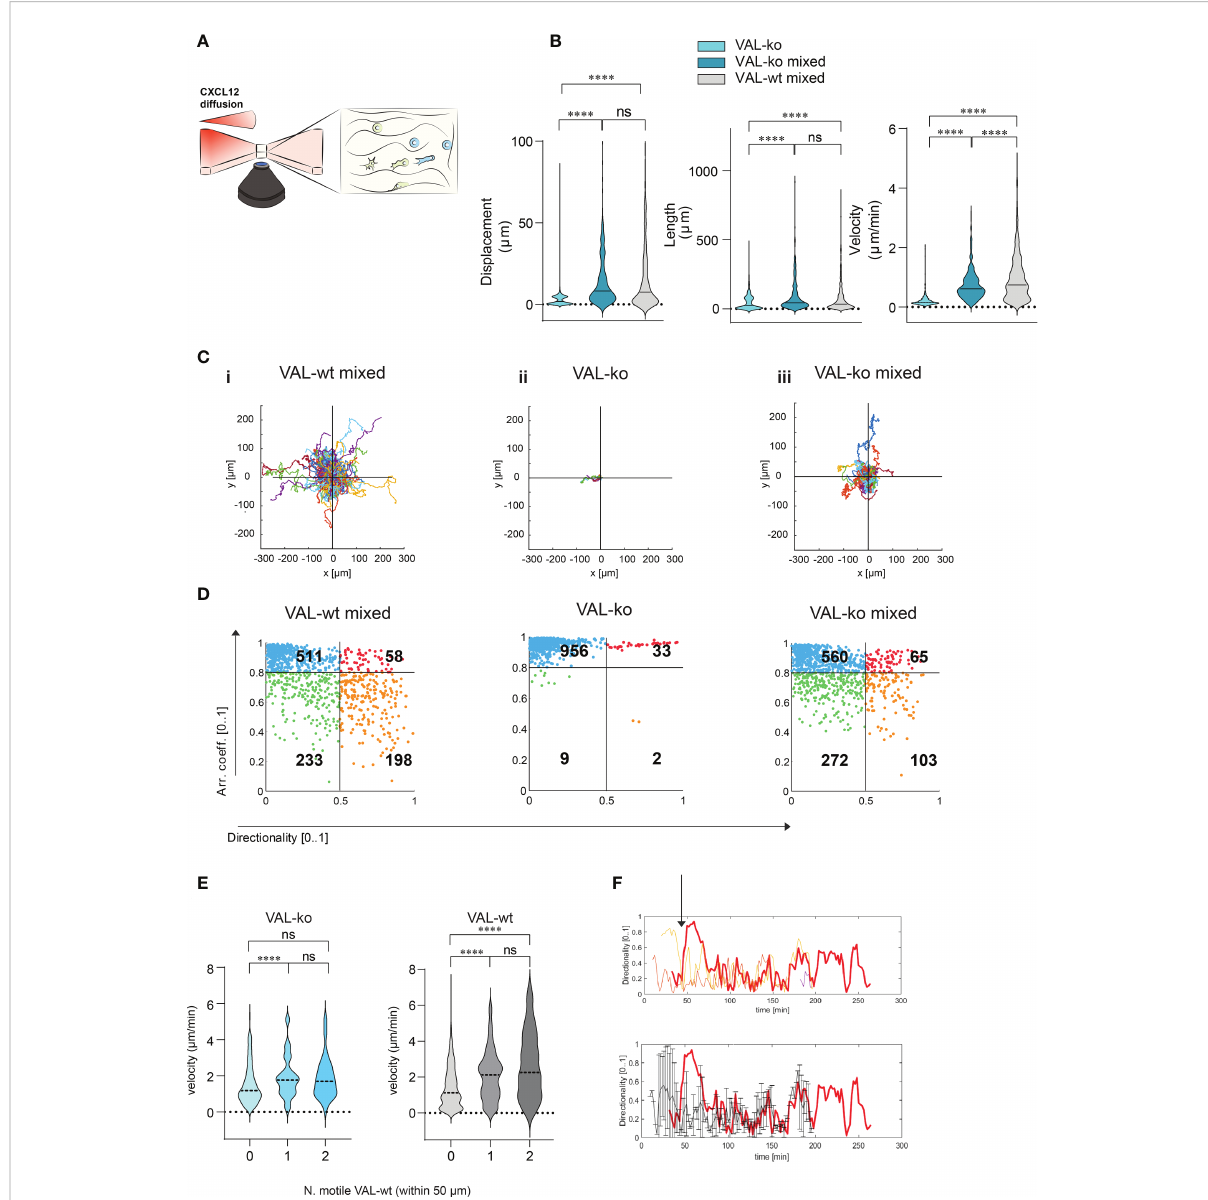
FIGURE 4 CXCL12 stimulated VAL-wt increase the 3D motility and directional migration of VAL-ko. (A) Schematic representation of 3D migration chamber showing a chemotactic gradient (CXCL12 diffusion) from left to right. (B) Violin plots showing displacement, length and velocity of VAL-ko alone (light cyan), VAL-ko in a 1:1 mixture with VAL-wt (VAL-ko mixed, dark cyan) and VAL-wt in the same mixture (VAL-wt mixed, grey). Tracking analyses were performed using Imaris software (means, Turkey ’ s multiple comparisons test, ONE-WAY ANOVA ns, p ≥ 0.05, ****p ≤ 0.0001). (C) Plots of tracks with a common origin. (i) VAL-wt mixed, (ii) VAL-ko alone, (iii) VAL-ko mixed. (D) Scatter plots of directionality vs arrest coef fi cients of 1000 VAL-wt mixed, VAL-ko alone, VAL-ko mixed. Gates with differently colored dots indicate four different motility patterns. (E) Violin plots of changes in velocity of VAL-ko and VAL-wt, relative to the number of motile (0, 1, 2) VAL-wt in a 50 µm radius (means,